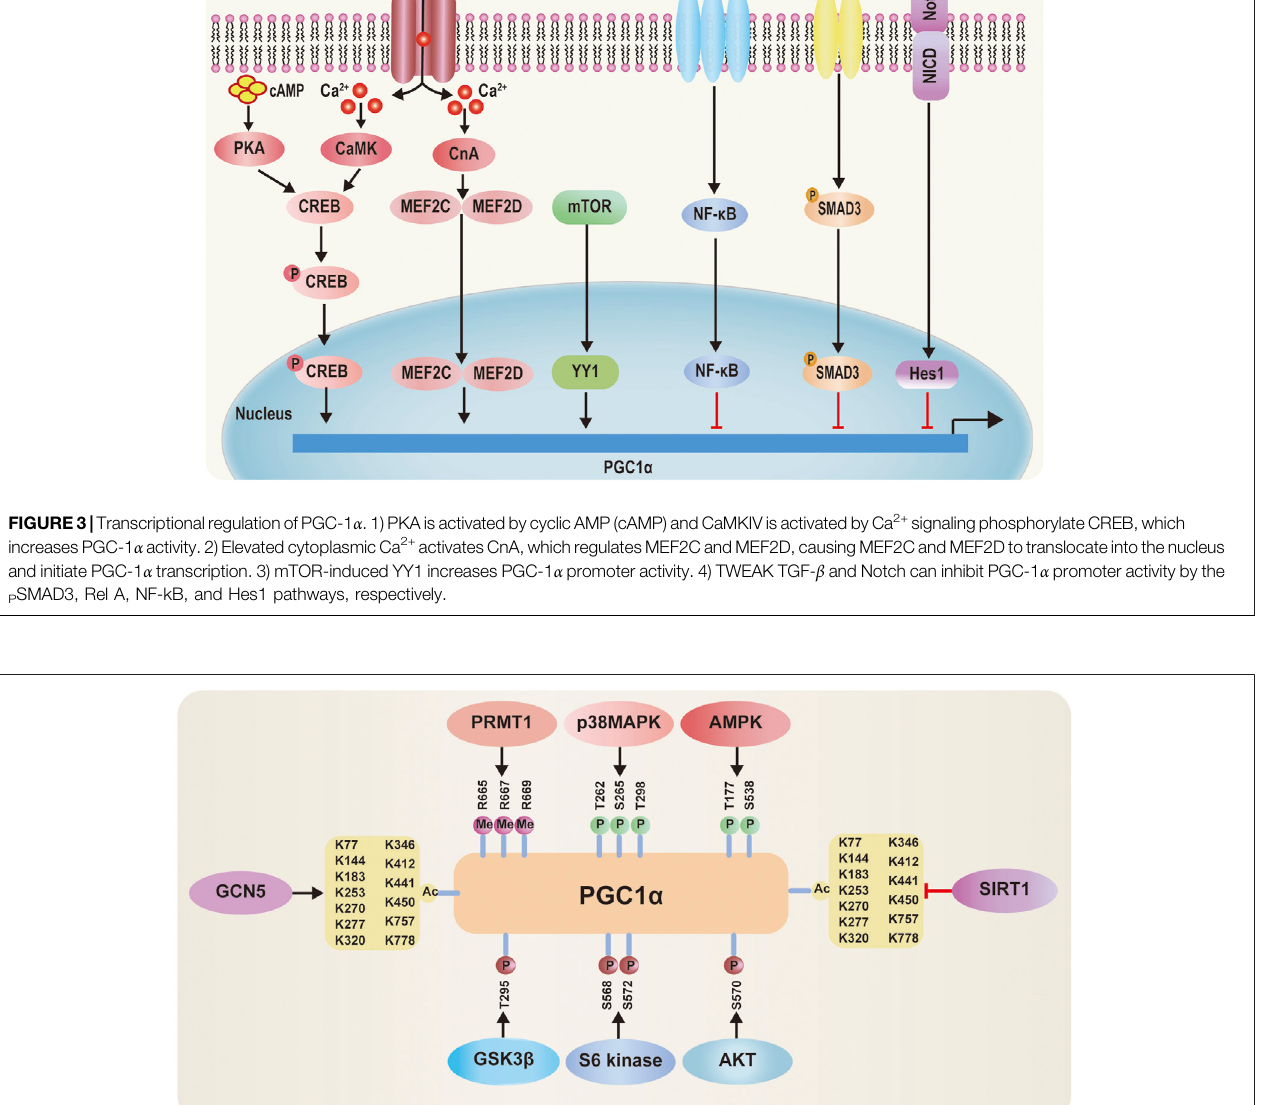
Frontiers in Cell and Developmental Biology |